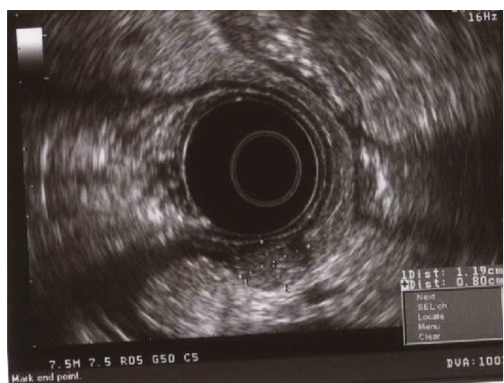
Figure 4: EUS picture of the subepithelial mass measuring 1 . 2 × 0 . 8cm in the body of the stomach. Hypoechoic mass emanating from the muscularis propria and with the typical appearance of gastrointestinal stromal